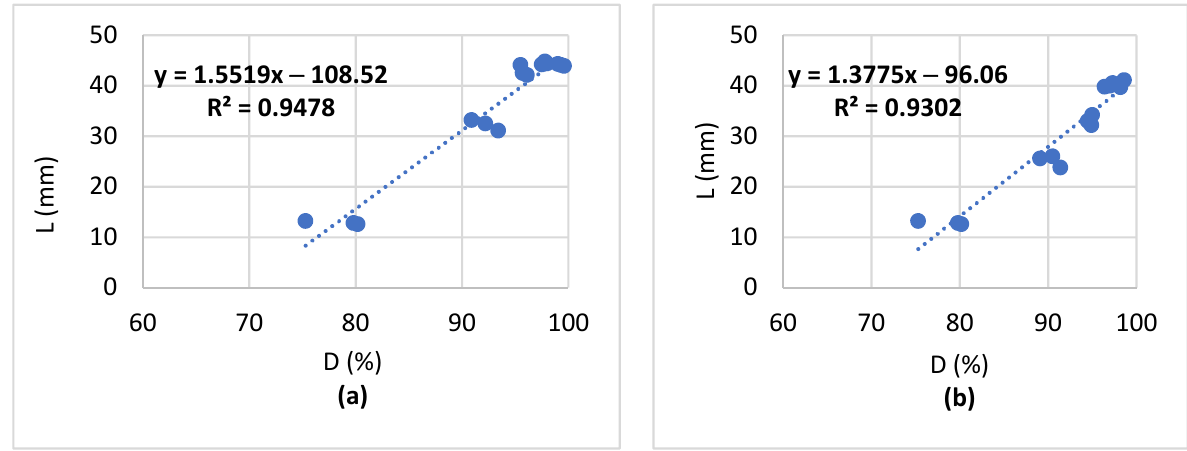
Figure 2. Correlations between durability and length of agripellets: ( a ) blends of olive pruning residues; ( b ) blends of vineyard pruning residues.